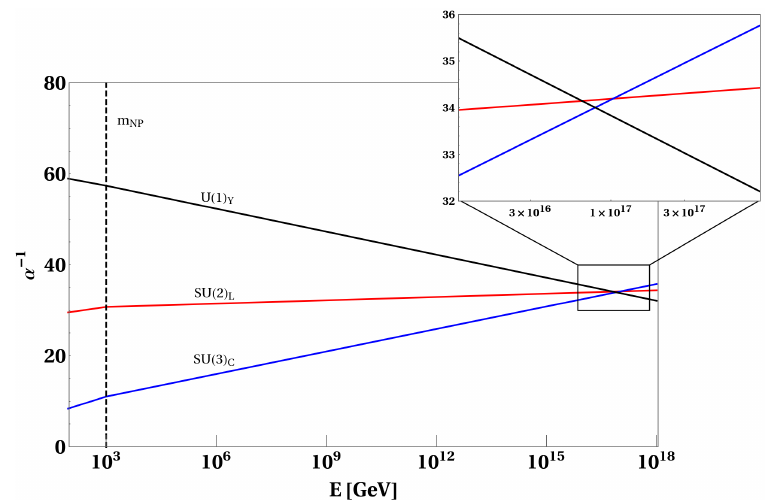
Figure 4 . Running of the gauge couplings for the model ( D, Q 1 , Π 1 , ω 1 ) from the T-I-2 class. This model unifies at a scale of m G ’ 10 17 . In this plot all BSM fields are added at a scale of m NP = 1